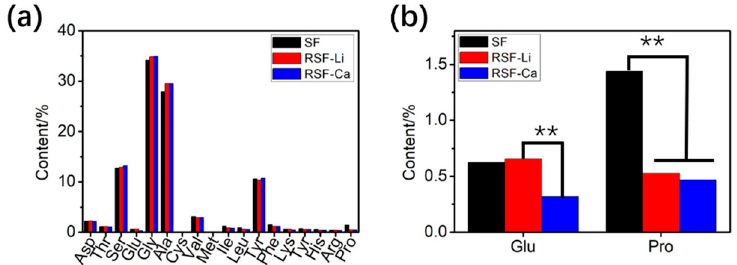
Figure 2. The amino acid composition of silk protein. ( a ) The content of 18 amino acids. ( b ) The content of Glu and Pro was significantly different during the dissolution process. (** p < 0.01).